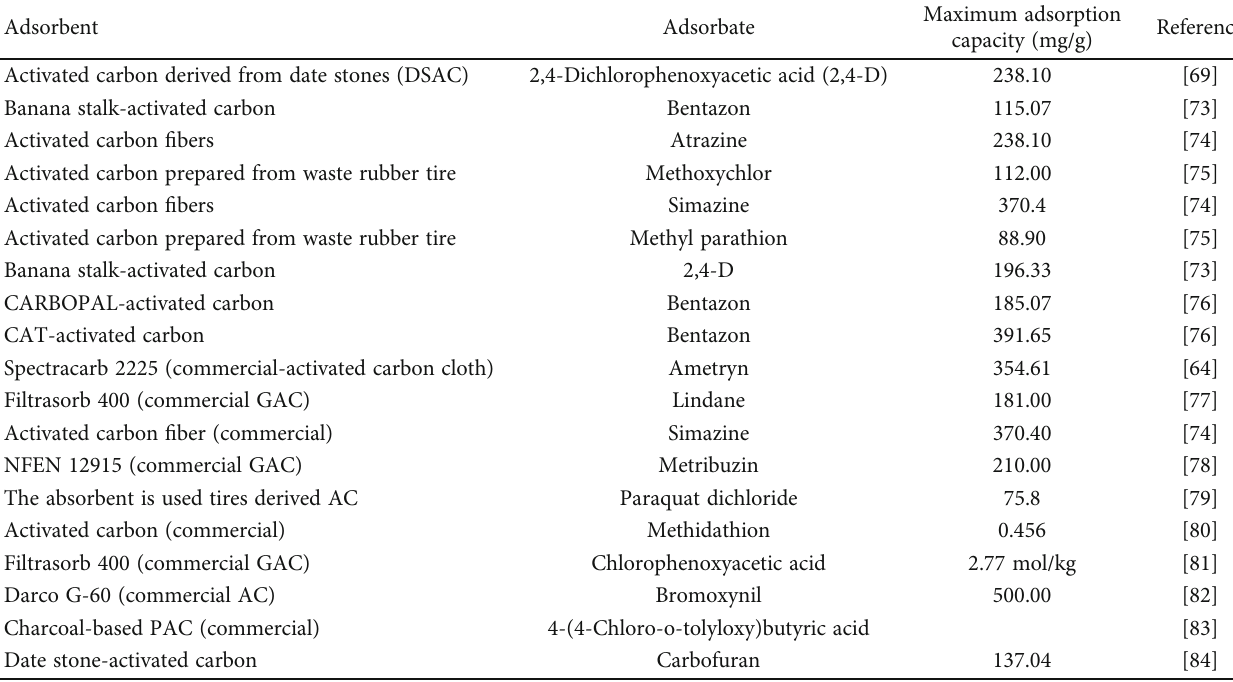
Table 4: Adsorption of various pesticides onto AC with reaction